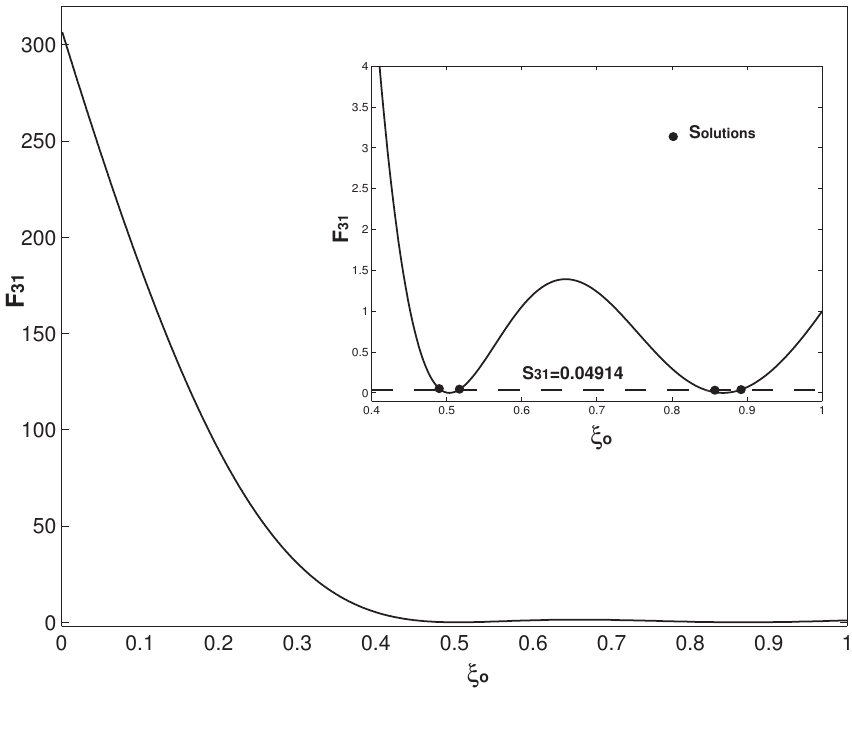
≤ 1 and there is only one ξ 31